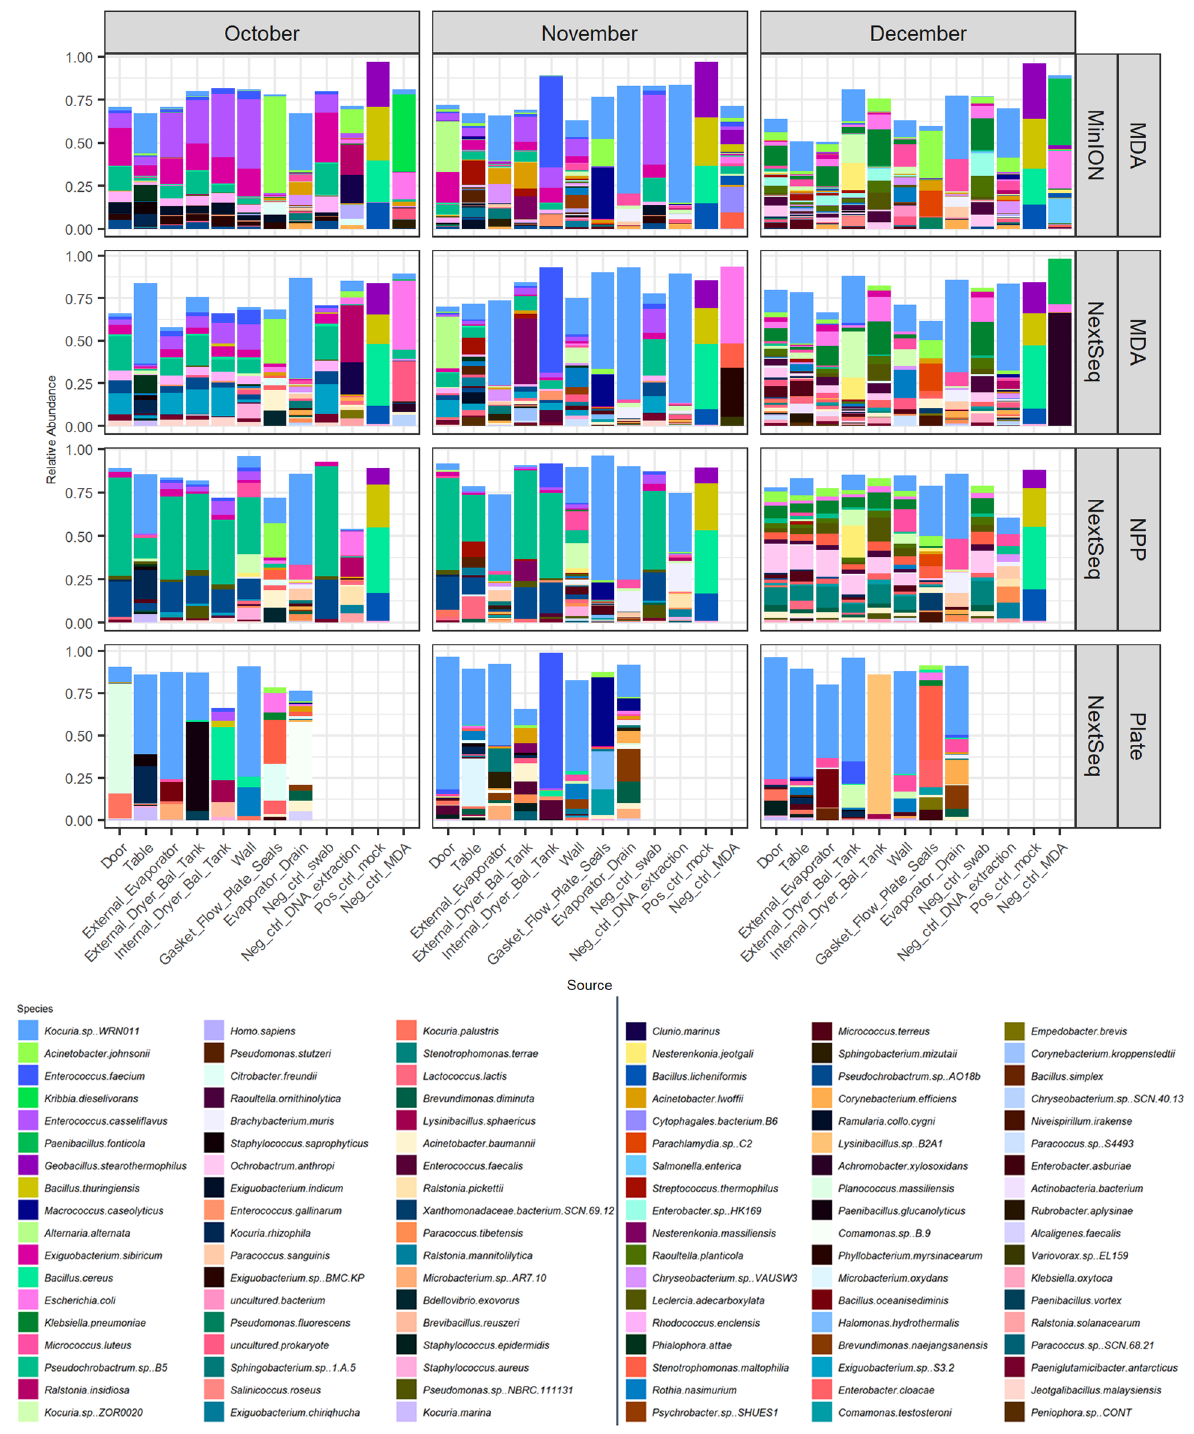
Fig. 3 Species level classi fi cation of MinION and NextSeq sequenced environmental samples. Taxonomic assignment of MinION and NextSeq sequenced samples generated following the use of different pre-processing and sequencing methods. Pre-processing methods include MDA ampli fi cation, no pre-processing (NPP), and spread plating on BHI before washing colonies, pelleting, and treating as a metagenomic sample (Plate). Species level classi fi cation was performed using LAST (for MinION) and Diamond (for NextSeq) alignment of reads against the NR database and classi fi cation with MEGAN (LR for MinION). Species present in at least 5% in at least one sample are